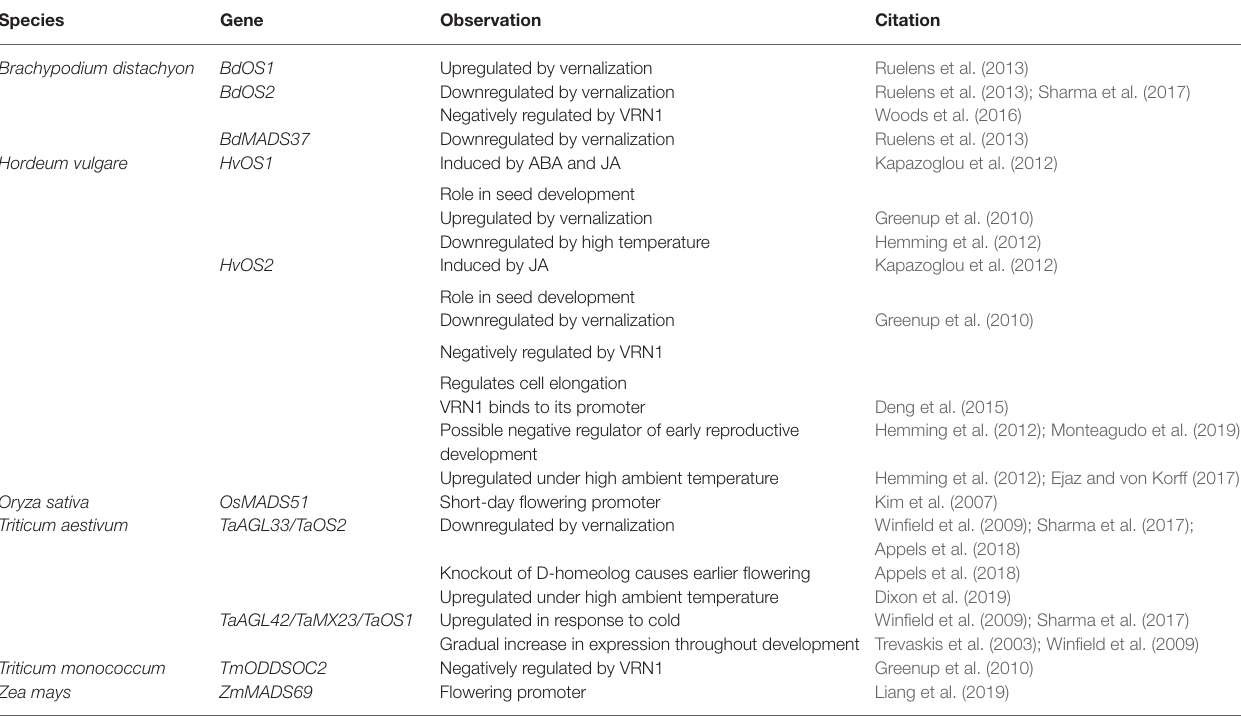
TABLE 1 | Overview of FLC gene function in cereals.